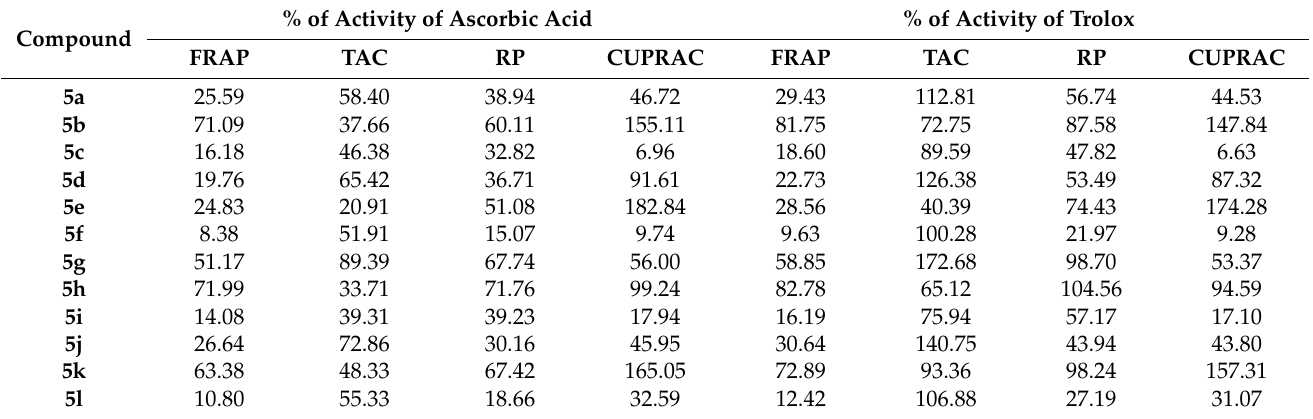
Table 4. Compounds 5b , 5g , 5h and 5k expressed a good capacity for electron donation. Table 4. Results of the Ferric Reducing Antioxidant Potential (FRAP), Total Antioxidant Capacity (TAC), Reducing Power (RP) and Cupric Reducing Antioxidant Capacity (CUPRAC) assays, expressed as the % activity of ascorbic acid and Trolox